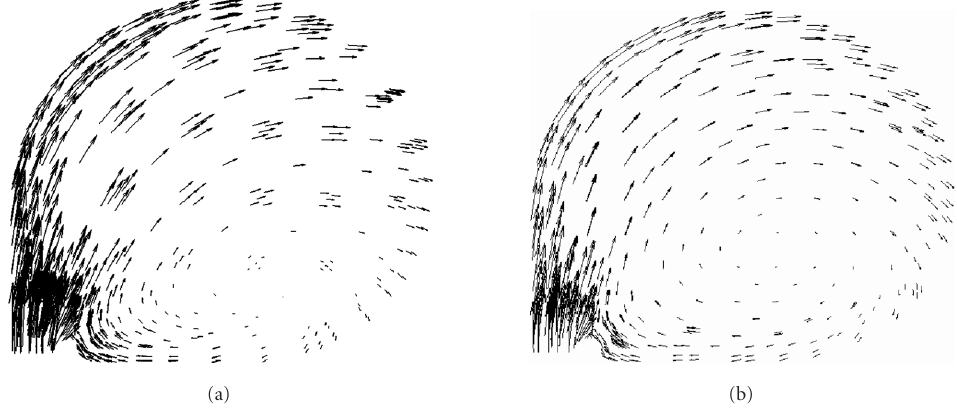
Figure 7: The velocity vectors at the volute exit ( θ = 360 ◦ ). Similar observations as in Figure 6 are made. (a) Sharp tongue. (b) Round tongue.